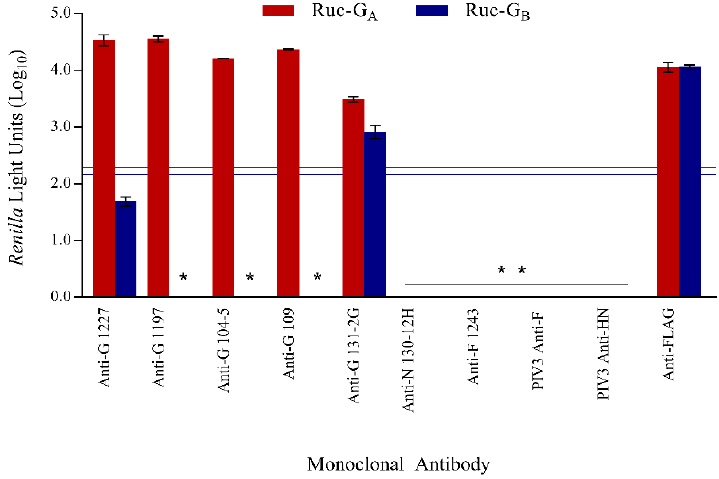
Figure 2. Specificity of the LIPS-G assays. Specificity of respiratory syncytial virus (RSV) LIPS-G assays in detecting anti-RSV-G IgG antibodies was shown using murine monoclonal antibodies. The mean reactivities against Ruc-G A and Ruc-G B antigens are shown in red and blue bars, respectively, and error bars represent standard deviations. Data were normalized against murine anti-FLAG antibody. Cutoff values for a positive signal were five standard deviations above the mean value of all four negative controls and are shown as horizontal red (Ruc-G A ) and blue lines (Ruc-G B ). * Represents a negative result.